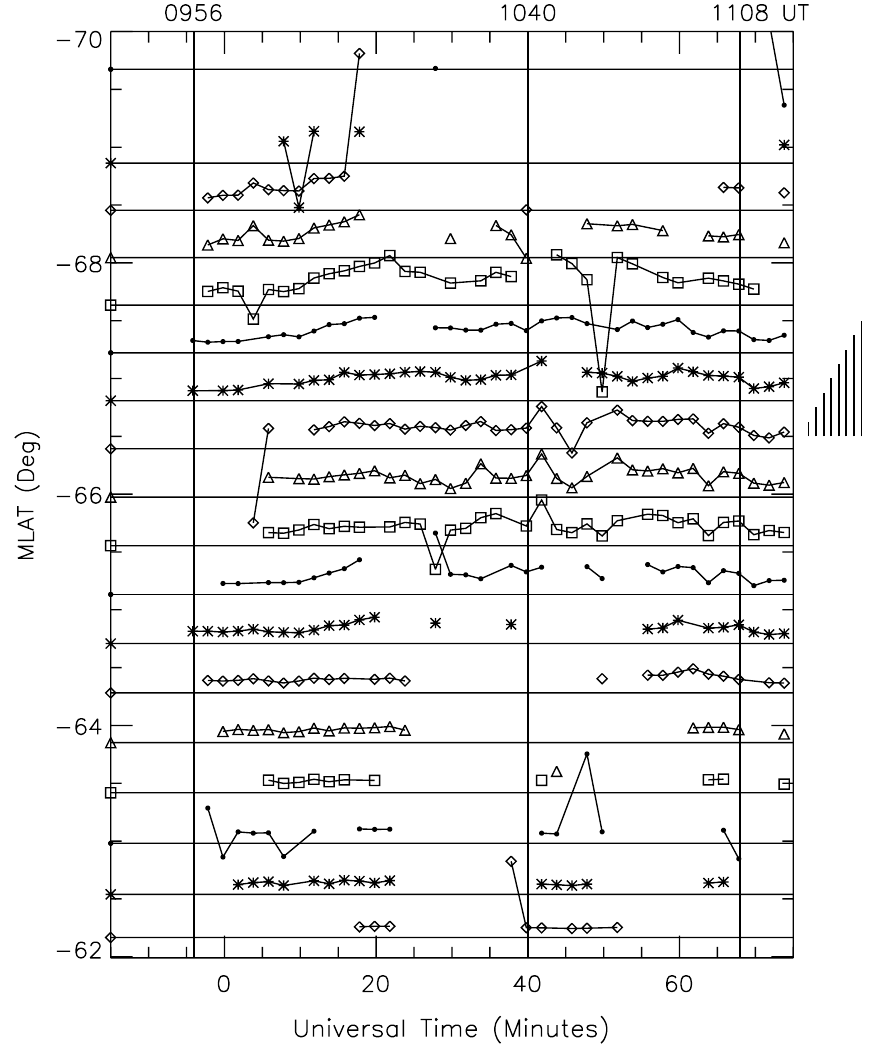
Fig. 6b. The same as Fig. 6a except for beam 0